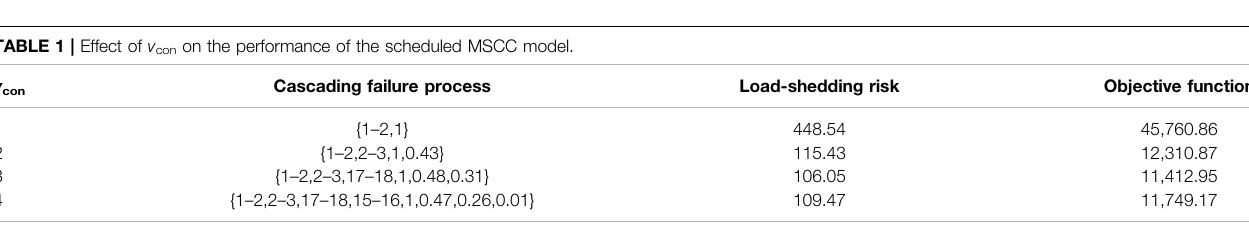
TABLE 1 | Effect of v con on the performance of the scheduled MSCC model.